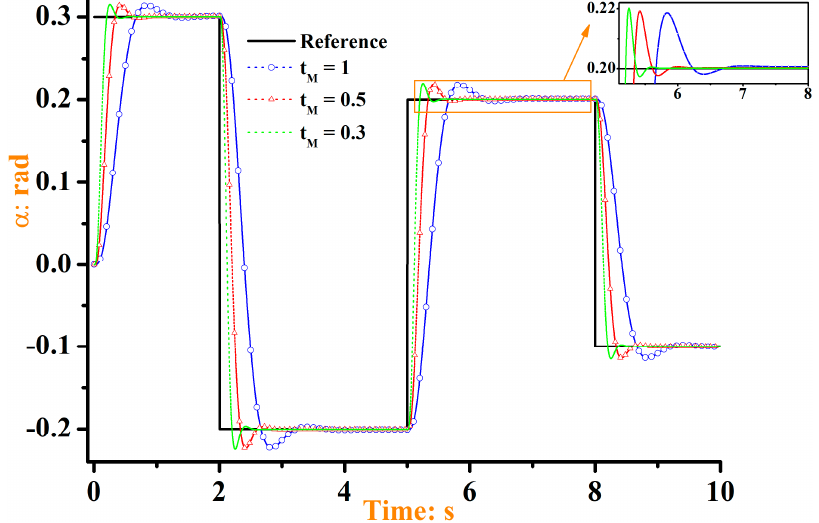
Figure 5. Group 2 with time-varying disturbance: Tail deflection